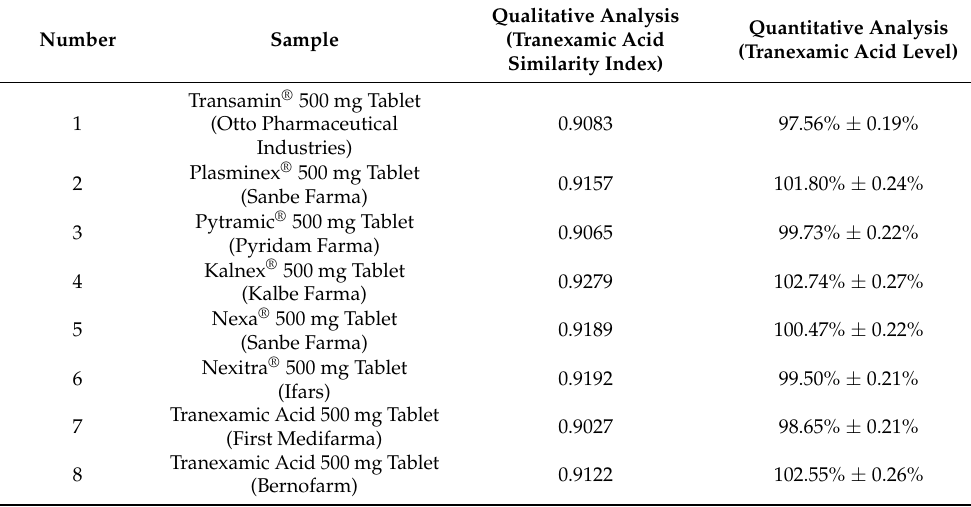
Table 4. Results for qualitative analysis and quantitative analysis of tranexamic acid in marketed tablets.